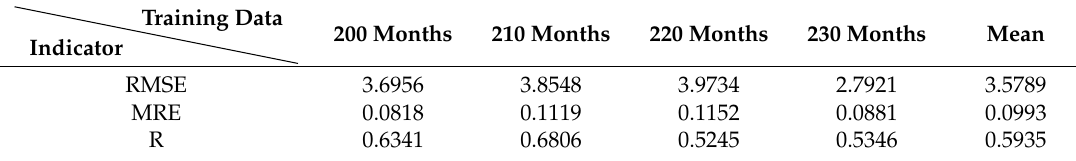
Table 4. Error analysis of WA-DBN prediction model with different training data.